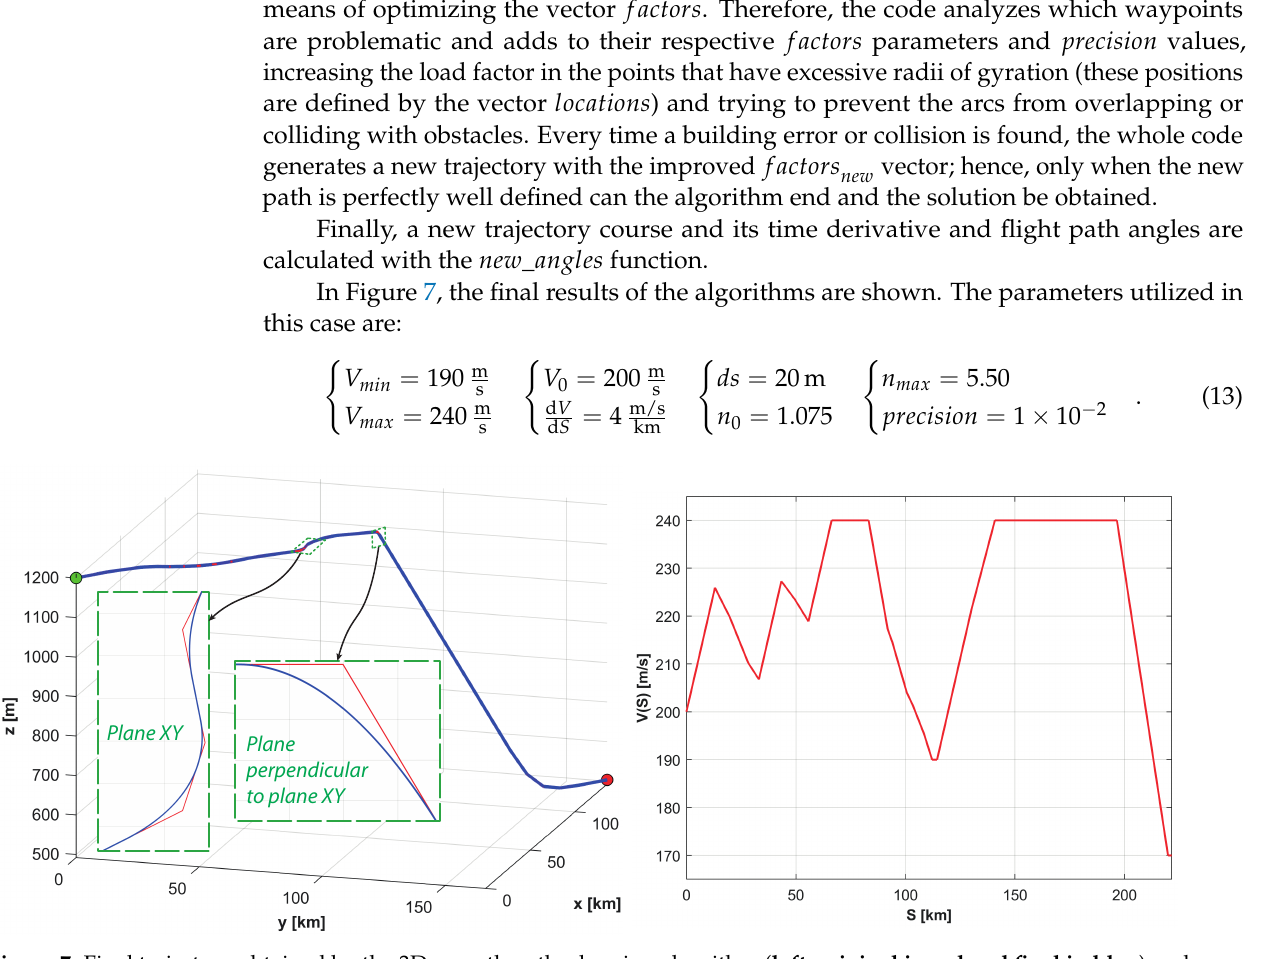
Figure 7. Final trajectory obtained by the 3D smooth path-planning algorithm ( left, original in red and final in blue ) and the velocity profile as a function of the curvilinear distance S ( right